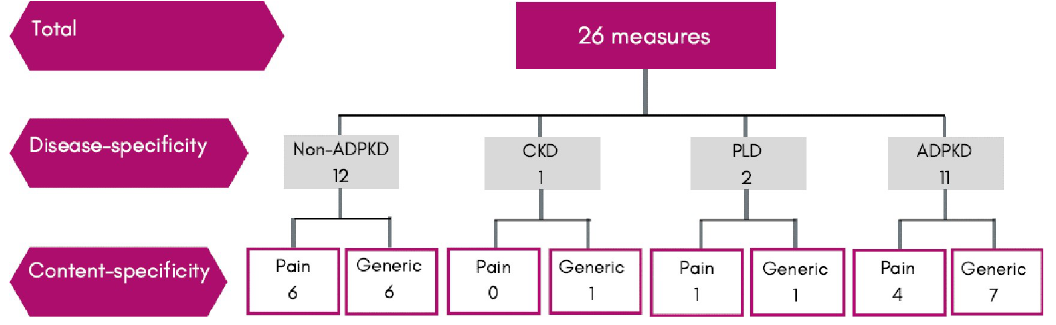
Fig 2. Type of measures used to assess pain in patients with